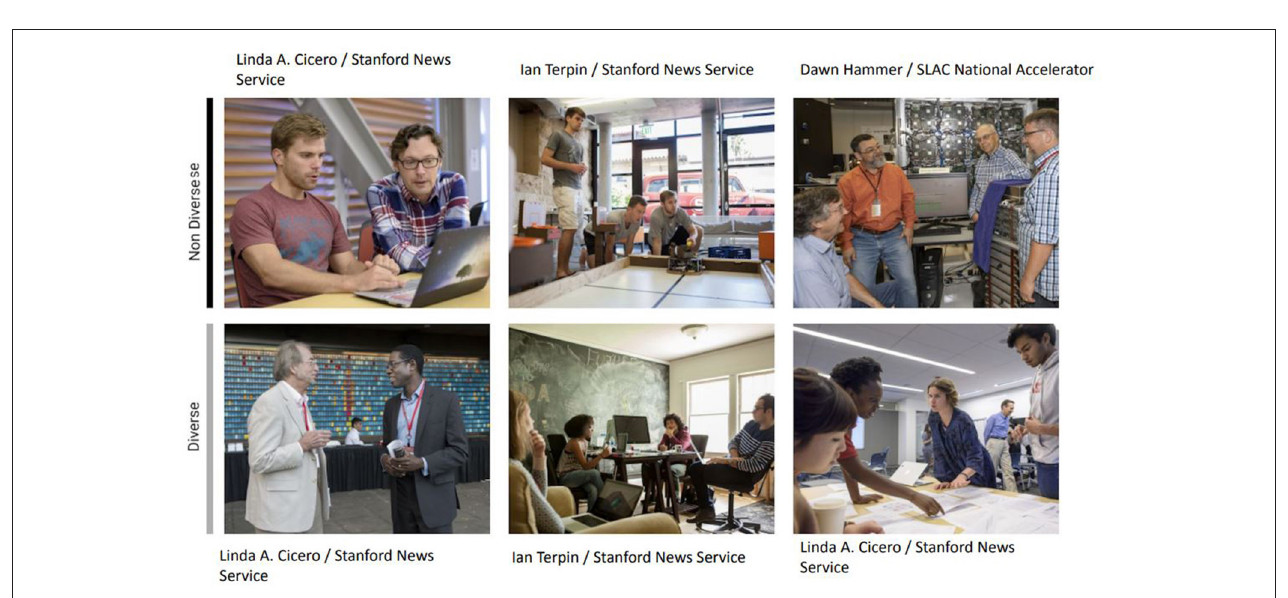
FIGURE 4 | Original diversity pictures framed inside the laboratory rooms shown in Figures 2 , 3 .